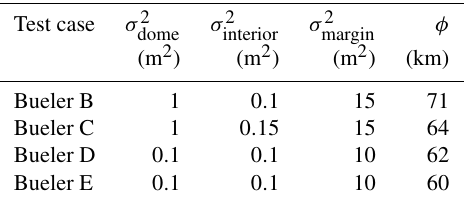
Table 4. Error-correcting process hyperparameters; σ 2 error-correcting process variance at the dome, σ 2 correcting process variance at the interior, σ 2 correcting process variance at the margin, and φ is the length scale parameter.